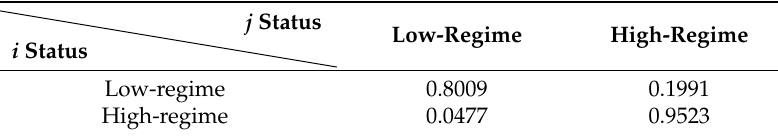
Table 10. Transition probability matrix of MRS